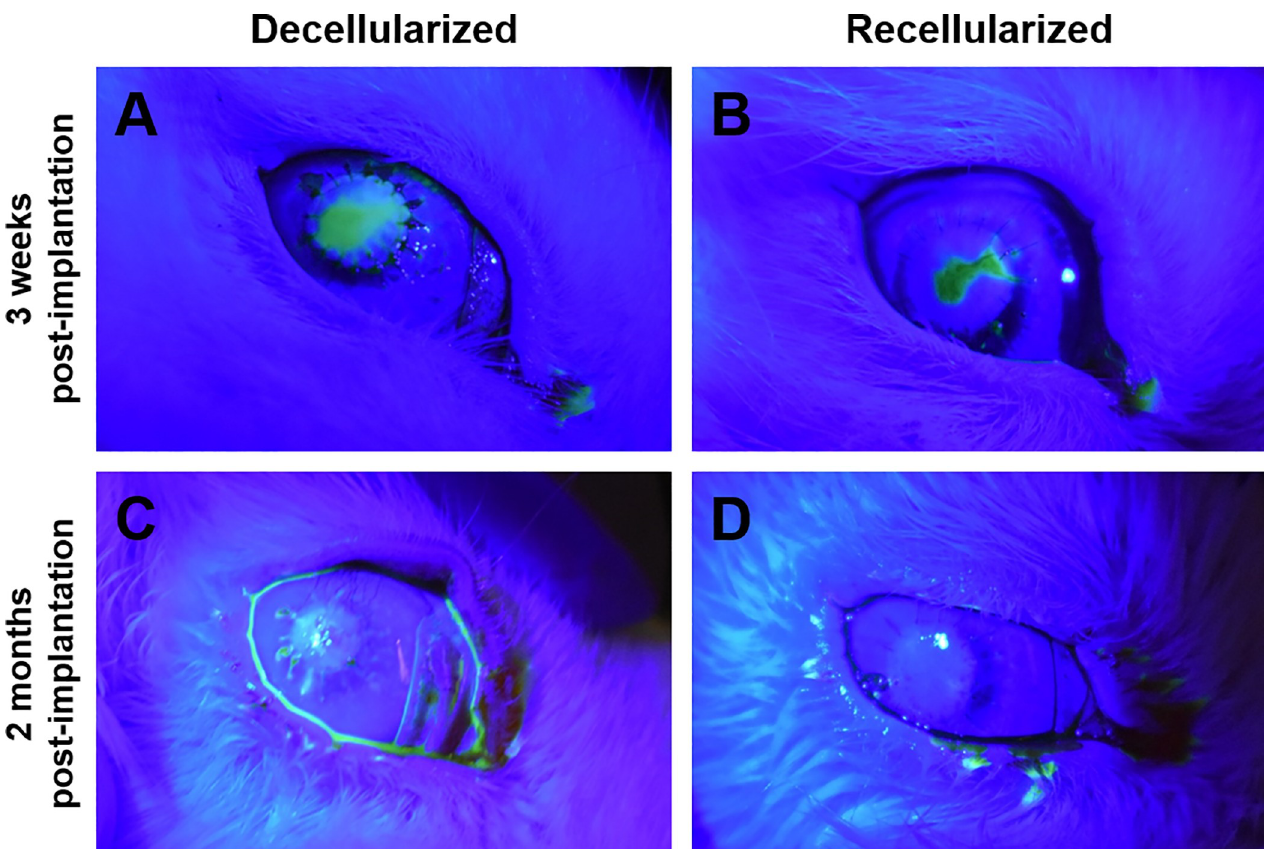
Fig 9. Fluorescein staining of the rabbit eye. A, C) 3 weeks and B, D) two months post-implantation. With both groups the epithelial barrier is not complete at the earlier time, but is intact later.